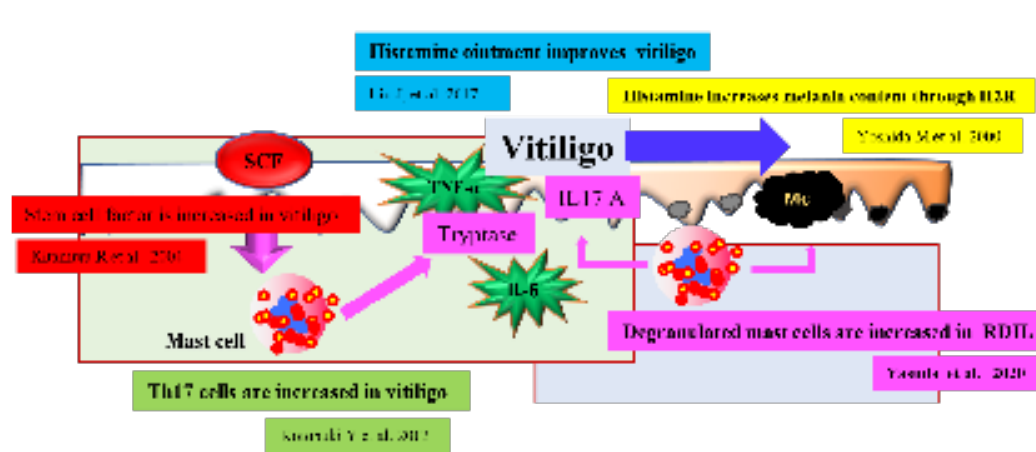
Figure 9. The illustration for the story of the two faces of mast cells in vitiligo. The story of our study was illustrated. H2R: histamine 2 receptor; Mc: